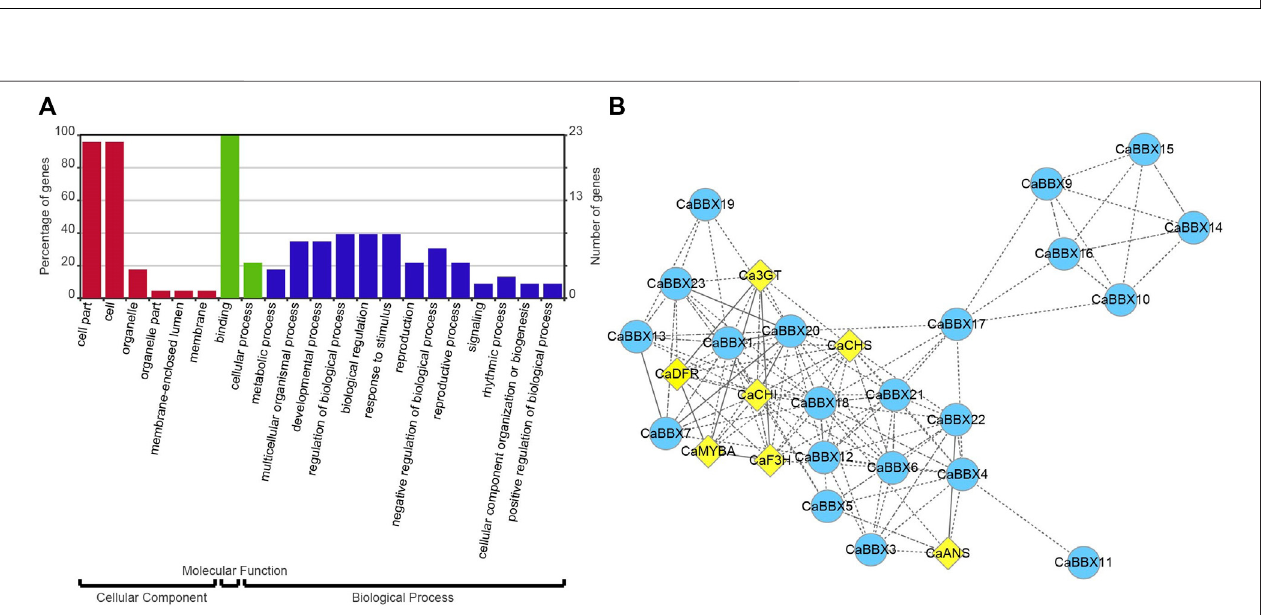
FIGURE 5 | (A) GO enrichment analysis of CaBBXs . The red bars represent cellular component, the green bars represent molecular function, and the blue bars represent biological process. (B) Co-expression analysis of CaBBXs and structural genes of the anthocyanin pathway. The yellow diamonds represent the structural genesoftheanthocyanin pathwayandthebluecirclesrepresent the CaBBX familyofgenes.Thelineindicatestheircorrelation;themoresolidistheline,thehigheristhe correlation.